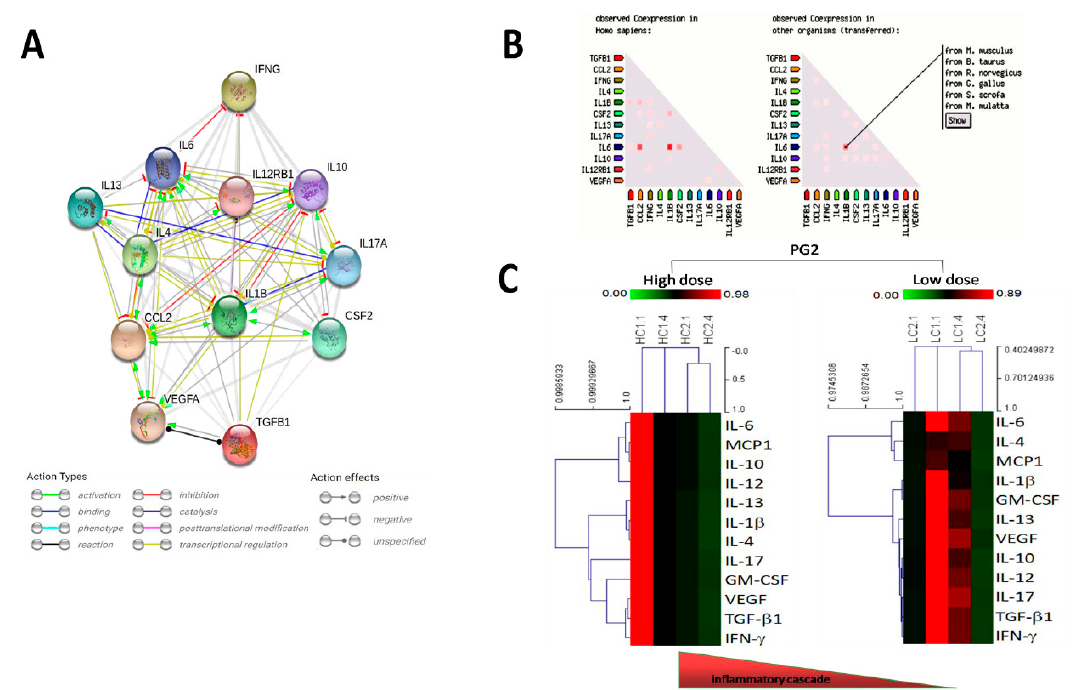
Figure 1. Astragalus polysaccharides (PG2)-induced improvement in Quality of life (QOL) is associated with changes in patients’ inflammatory cytokine profiles. ( A ) Visualization of the protein-protein interaction networks of the inflammatory cytokines of our cohort using STRING: functional protein association networks (STRINGdb) platform. ( B ) Representative data from gene coexpression analysis of the inflammatory cytokines of our cohort. ( C ) Unsupervised hierarchical cluster heatmap showing the high or low dose PG2-induced changes in expression of our cohort inflammatory cytokines over the study course.